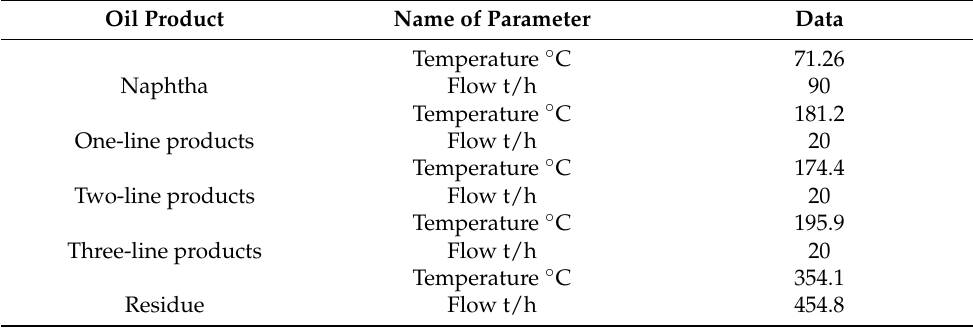
Table 1. The basic parameters of side line products of the atmospheric column.